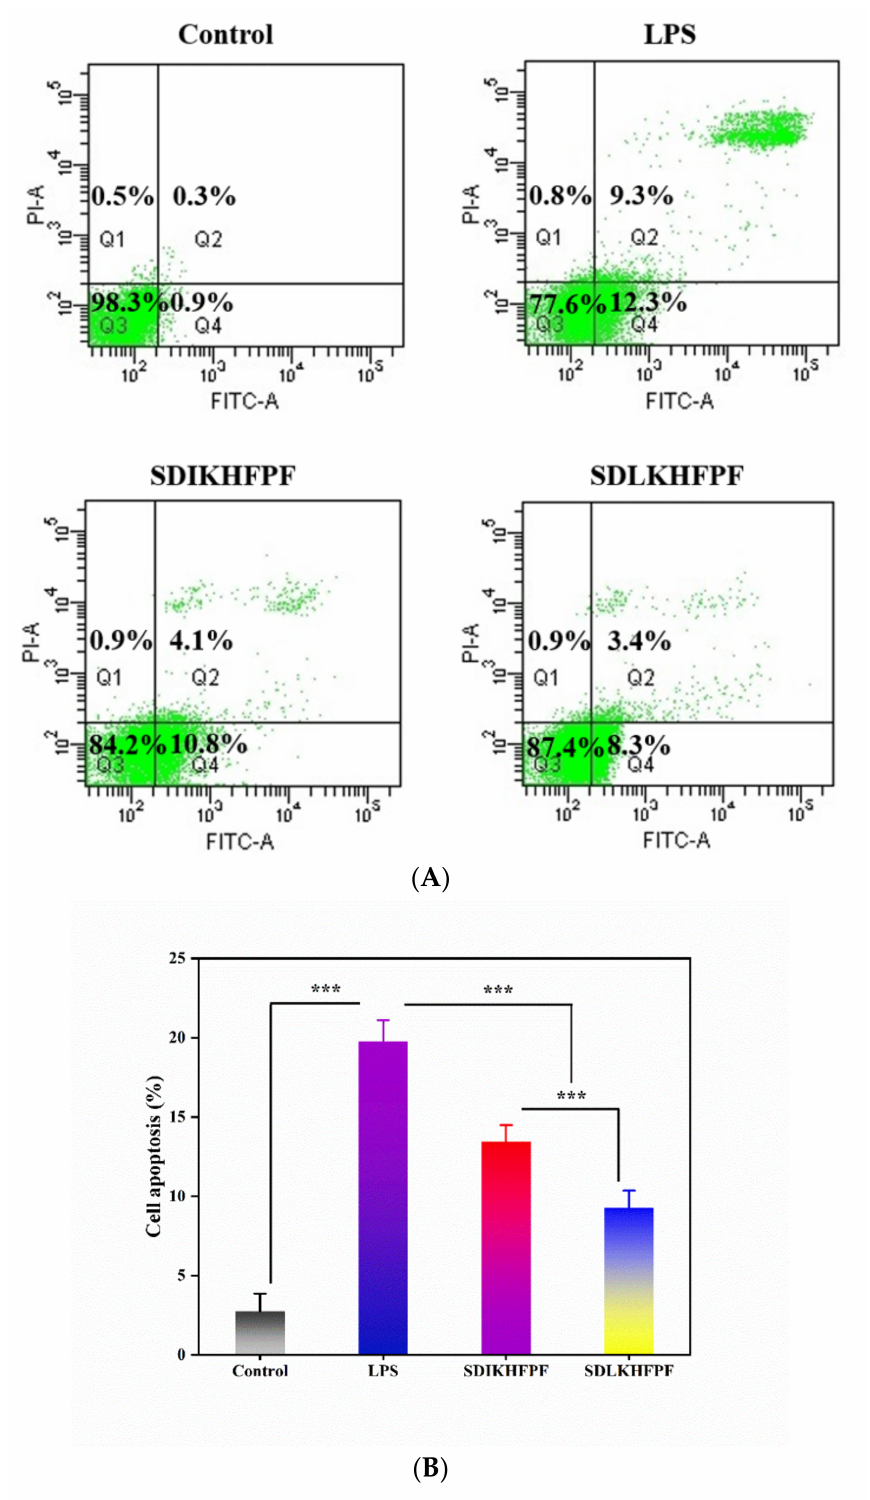
Figure 3. ( A ) Apoptosis was measured with annexin V/PI staining combined with flow cytometry. ( B ) Quantitative analysis of apoptosis was performed by combining the percentages of early (Q2) and late (Q4) apoptosis. Data were represented as mean ± SD ( n = 3), ***: p <